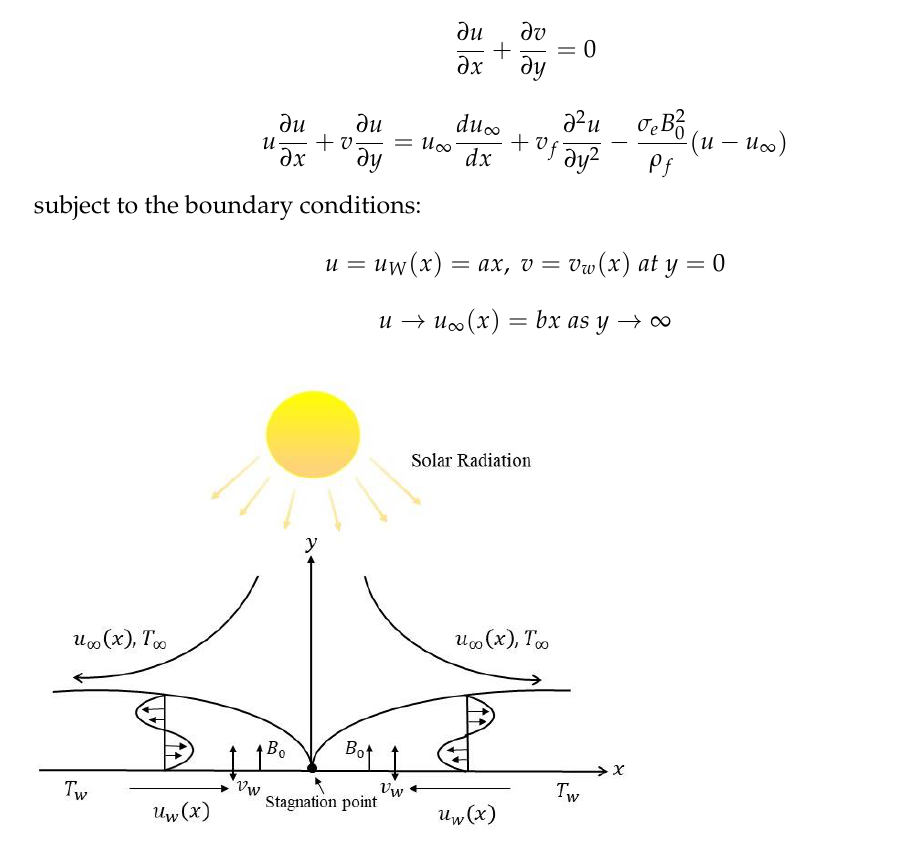
Figure 1. Diagram of the present